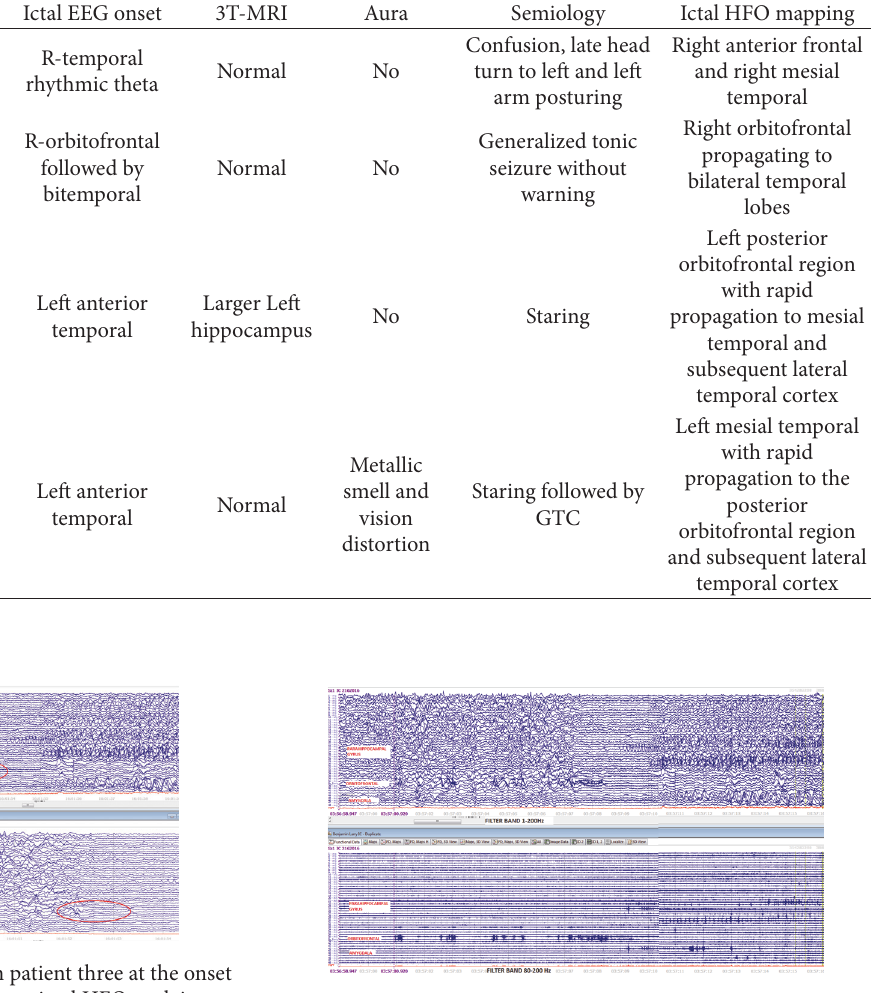
Figure 2: Comparison of HFO activity using a wide band (1– 200 Hz) versus a ripple band (80–200